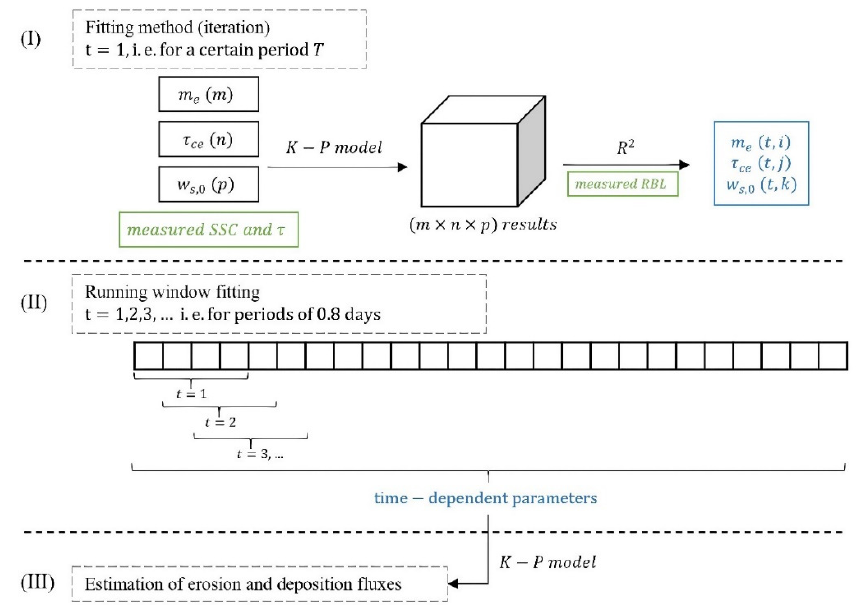
Figure 3. Schematized procedure for data fitting. The general approach ( I ) is to compute a large number of possible relative bed levels ( RBL ), realized with a range of K-P model settings, by varying τ ce , m e , and/or w s ,0 , and fitting these to observed RBL using an R 2 . Then the approach is repeated with a running window fitting method ( II ), providing a timeseries of freely varied input parameters. These time-varying parameters are subsequently used to compute erosion and deposition fluxes ( III